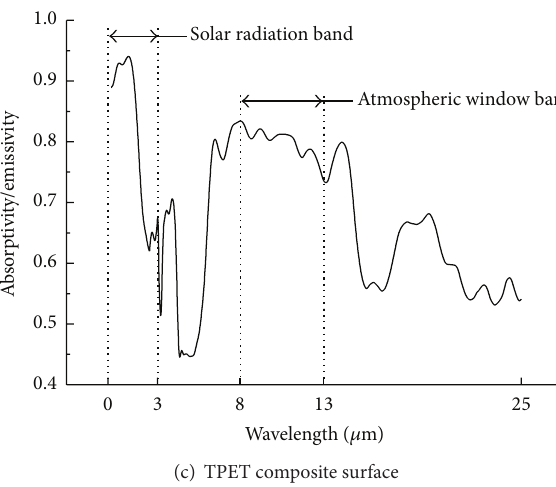
Figure 4: Spectral absorptivity (emissivity) of three kinds of real surfaces.